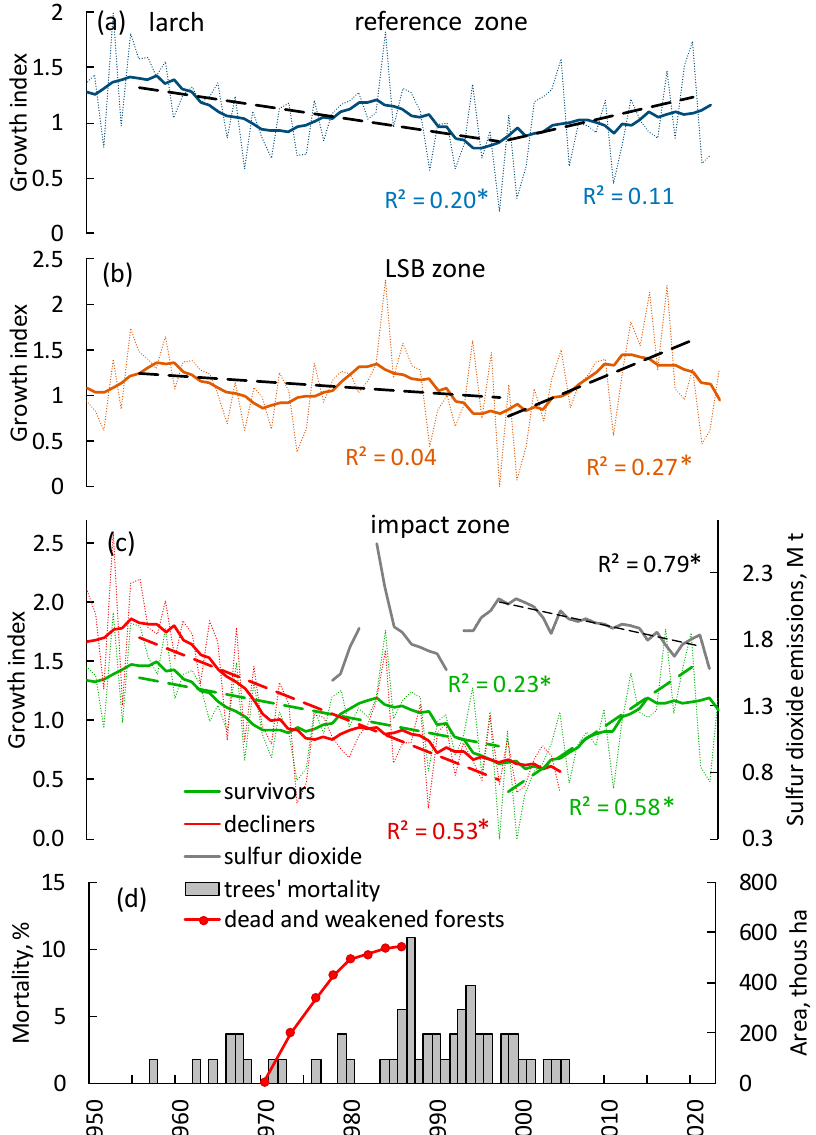
Figure 6. GI dynamics of larch trees in the ( a ) reference and ( b ) LSB zone. ( c ) Comparative GI dynamics of “survivors” and “decliners” larch trees and sulfur dioxide emission in the impact zone. Solid lines indicate an 11-year moving average. ( d ) Tree mortality dates (gray columns; dendrochronology-derived values) and the total area of dead and weakened forests (red curve; based on [35] data; see also Figure A1). Mortality is the percent of trees that died in the given year. Stars (*) indicate significant trends at p < 0.05.